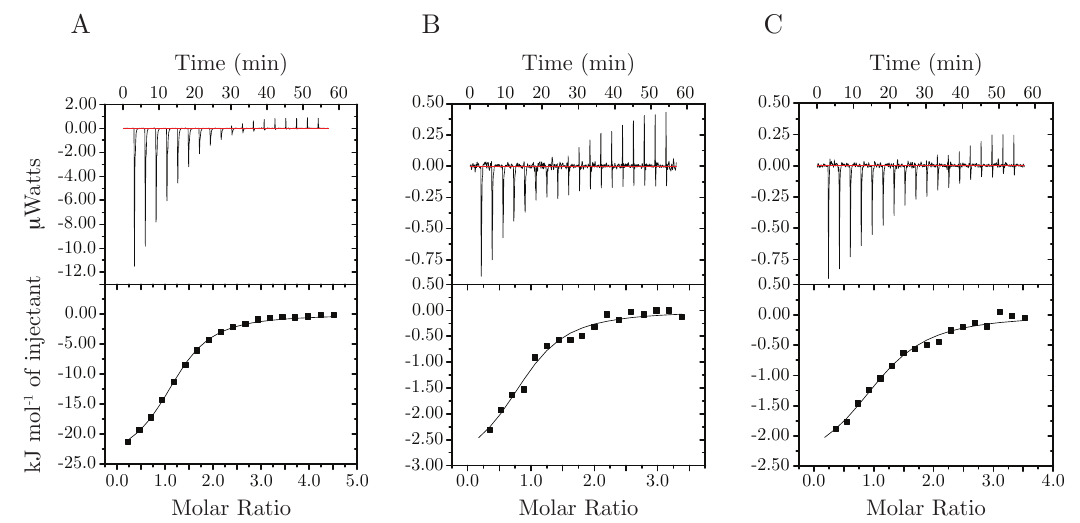
Figure 10. ITC measurements of interactions between Hst5 variants and Zn 2+ . Plots showing ITC data representative of the experiments. Titration of Zn 2+ with ( A ) WT Hst5, ( B ) Hst5 DZM , and ( C ) Hst5 ZM